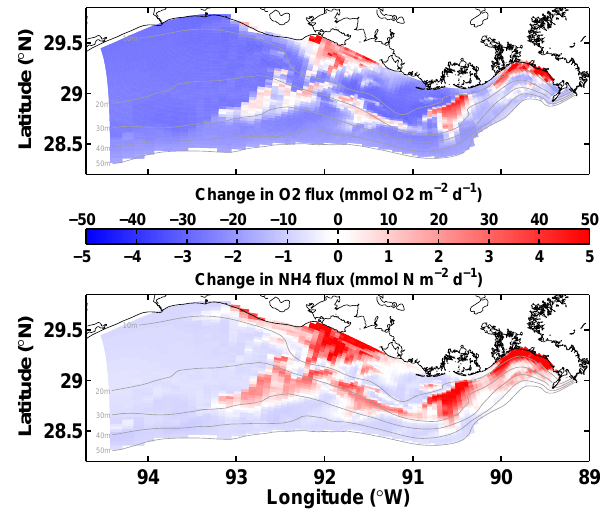
Figure 12. Difference between parameterized oxygen (top panel) and ammonium (bottom panel) fluxes and fluxes simulated with the H&D parameterization on 15 August